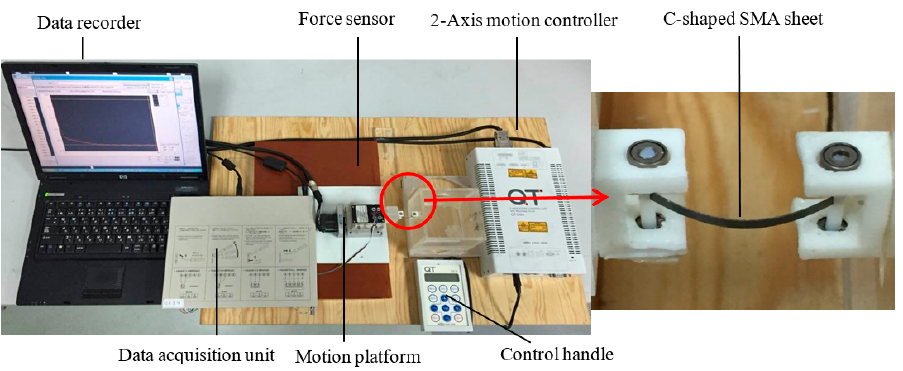
Figure 7. Experimental setup validating the generalized design method.